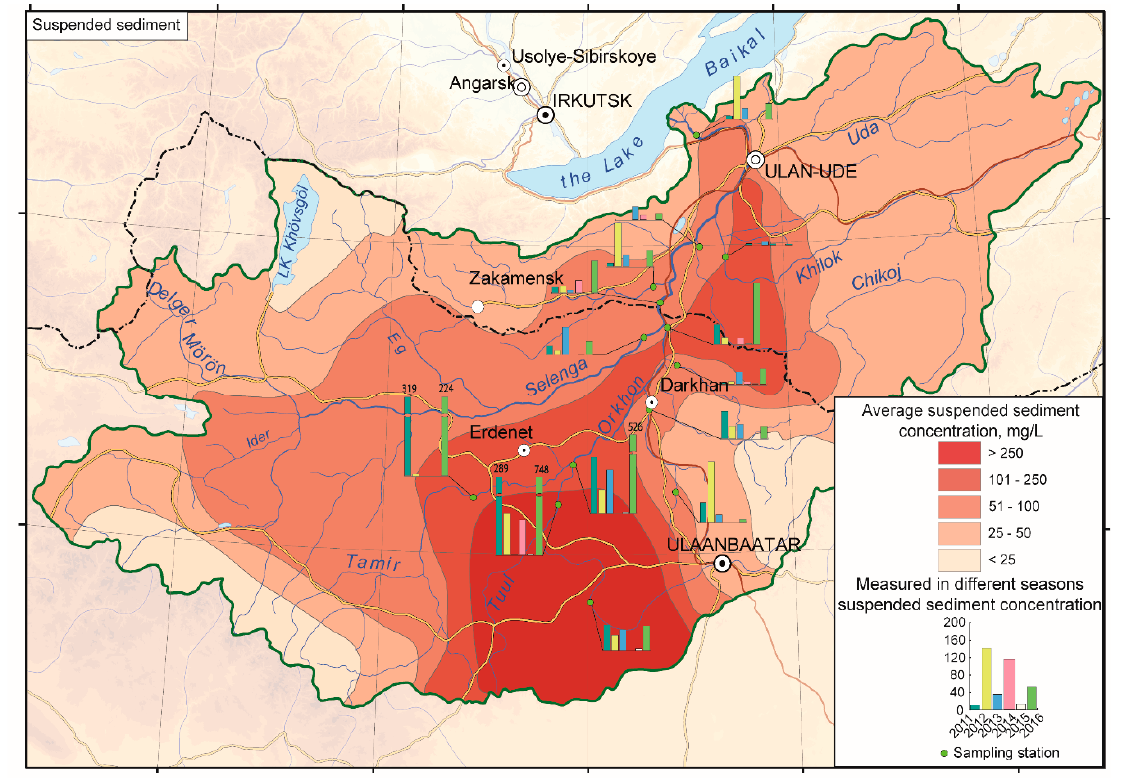
Figure 4. Spatial distribution of the suspended sediments concentration (g / m 3 ) in the Selenga River basin.